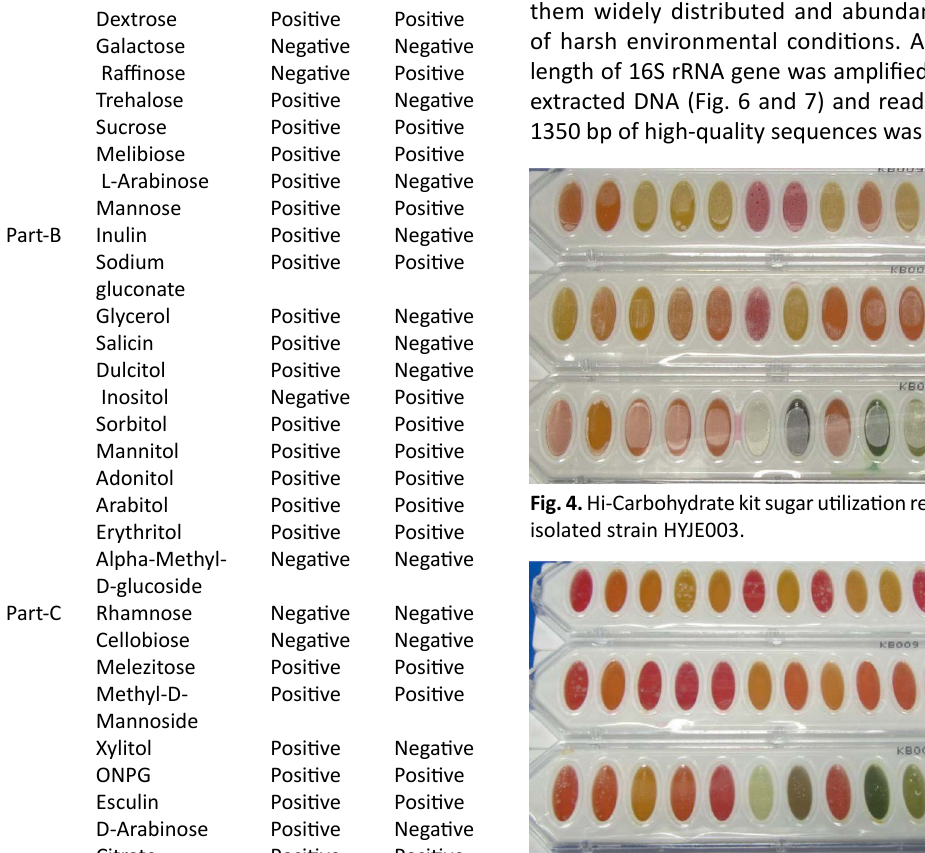
Fig. 5. Hi-Carbohydrate kit sugar utilization result for the isolated strain HYJE005.